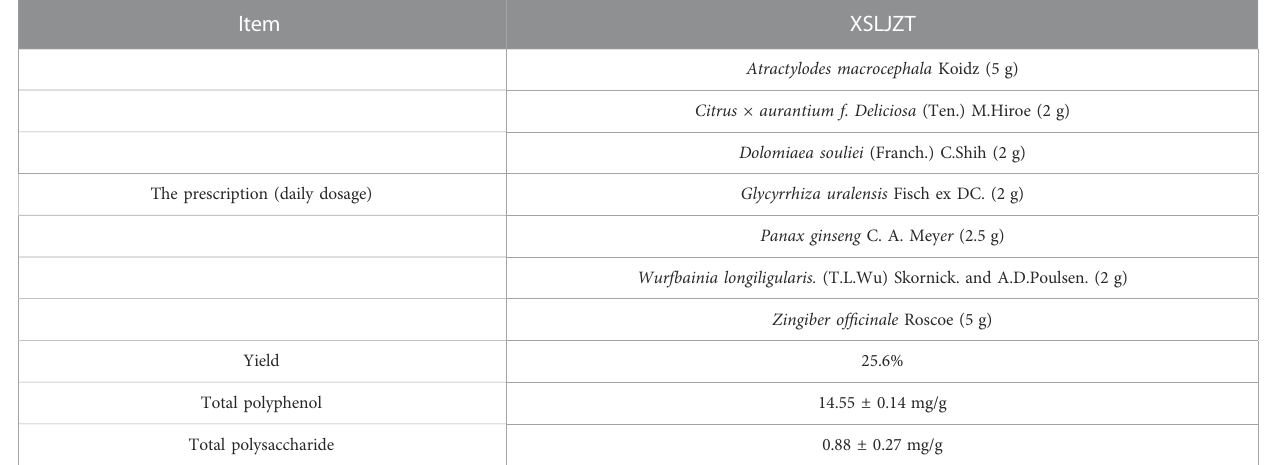
TABLE 1 The prescription and phytochemical compositions of the Xiang Sha Liu Jun Zi Tang water extract.